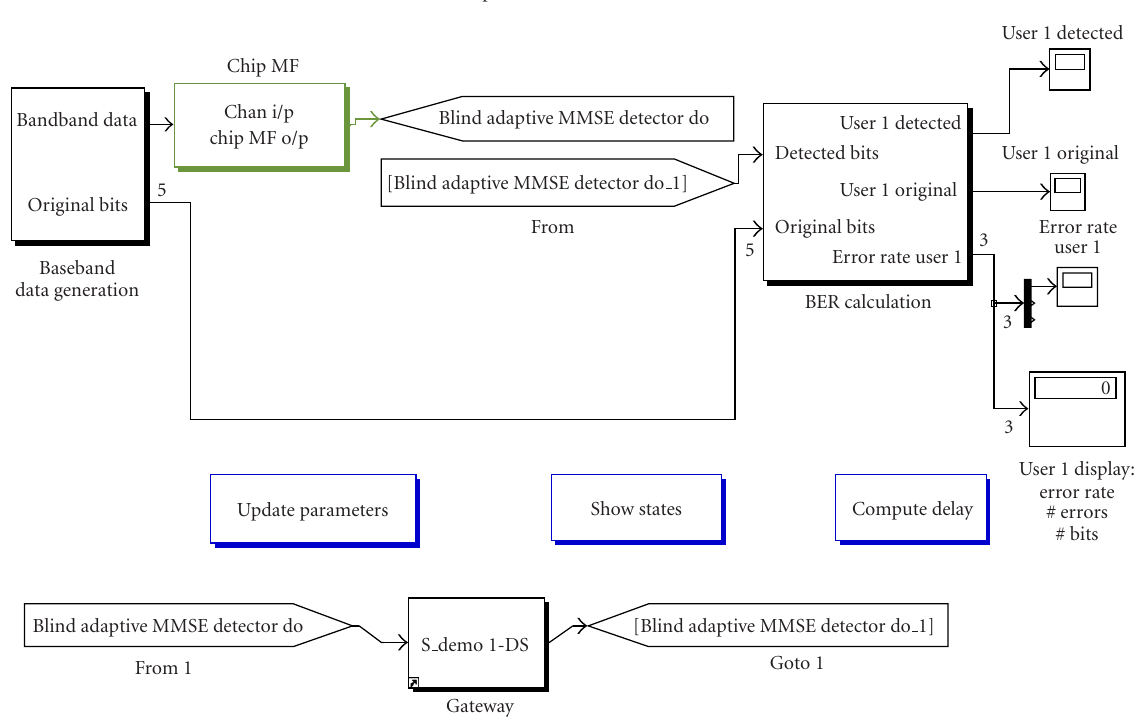
Figure 12: The host portion of the RENE CDMA testbed after separation by the